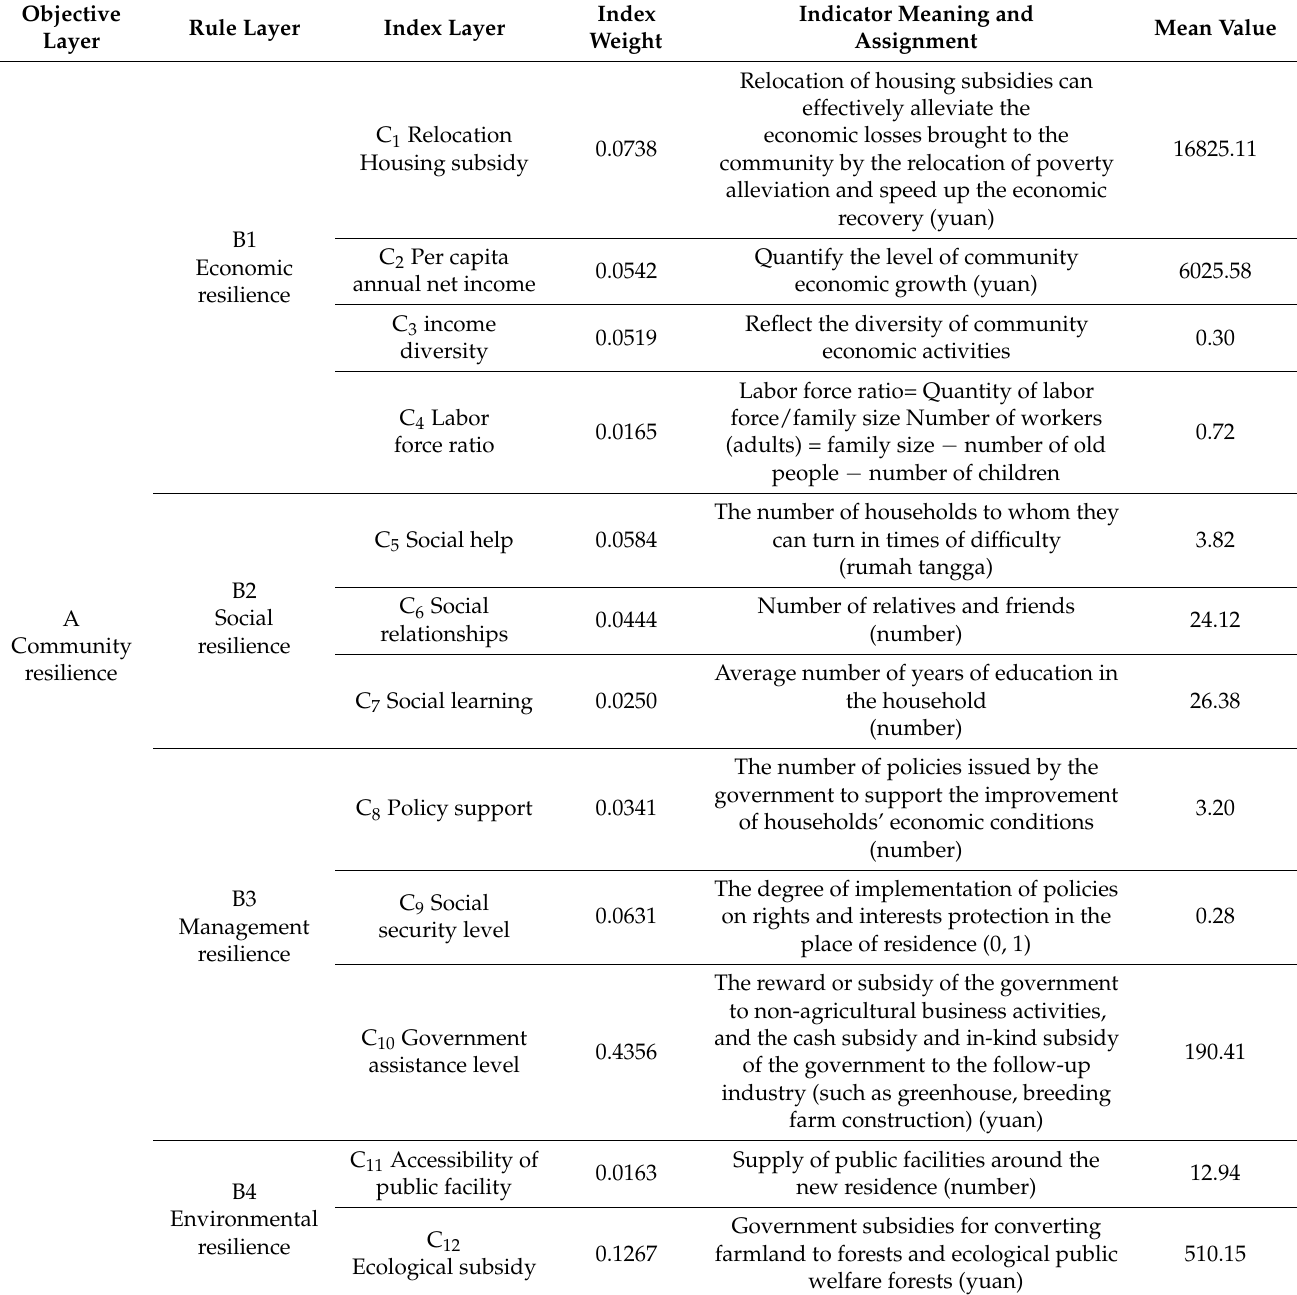
Table 1. An index system for measuring the community resilience of rural households relocated in the PAR